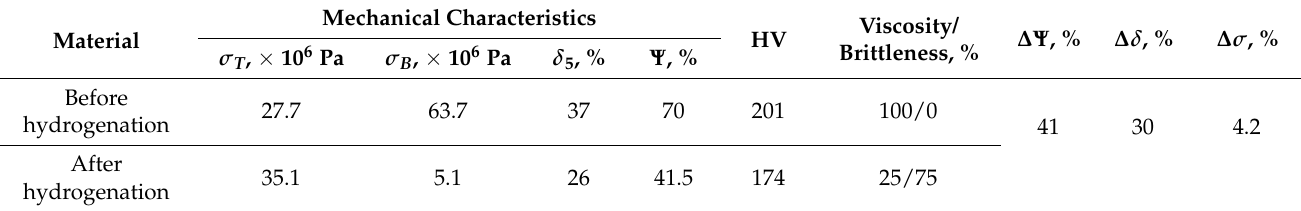
Table 8. Mechanical properties of 20YuCh steel samples before and after hydrogenation